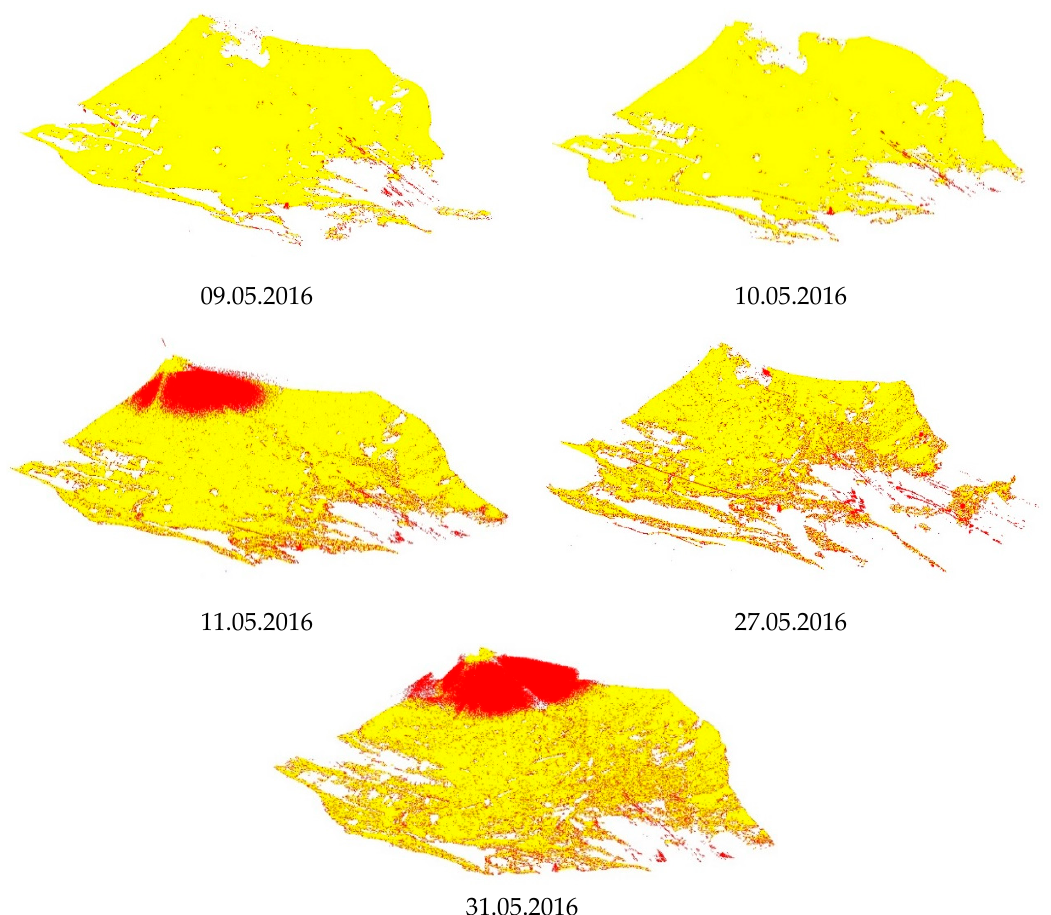
Figure 5. Classified 3D raw point clouds for each TLS scan: red points depict noise class and yellow points depict non-noise class.